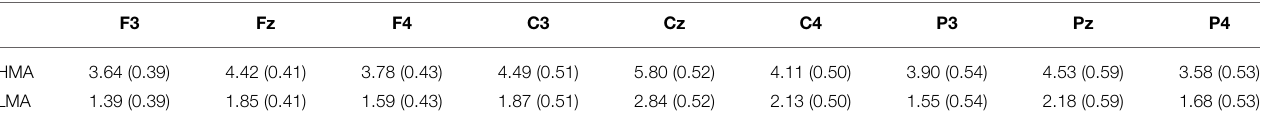
TABLE 3 | Mean amplitudes (in µ V) and standard error (in brackets) for the P2 component in the verification phase (175–225ms) for the HMA and LMA groups.